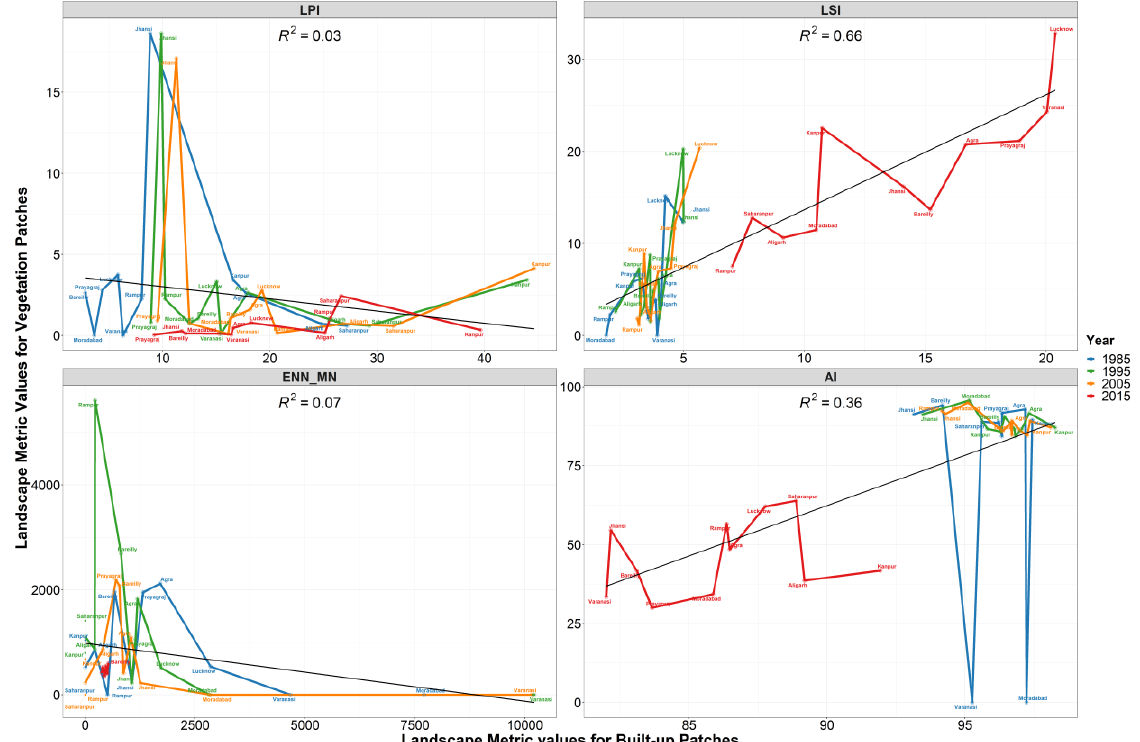
Figure 5. Relationship between landscape metrics for Built-up and Vegetation patches across 11smart cities of Uttar